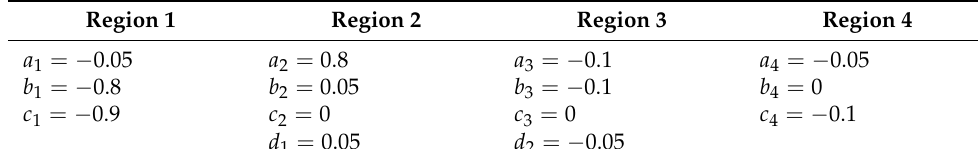
Table 2. Coefficients of the parameters depending on the case of infection effects reduction. Region 1 Region 2 Region 3 Region 4